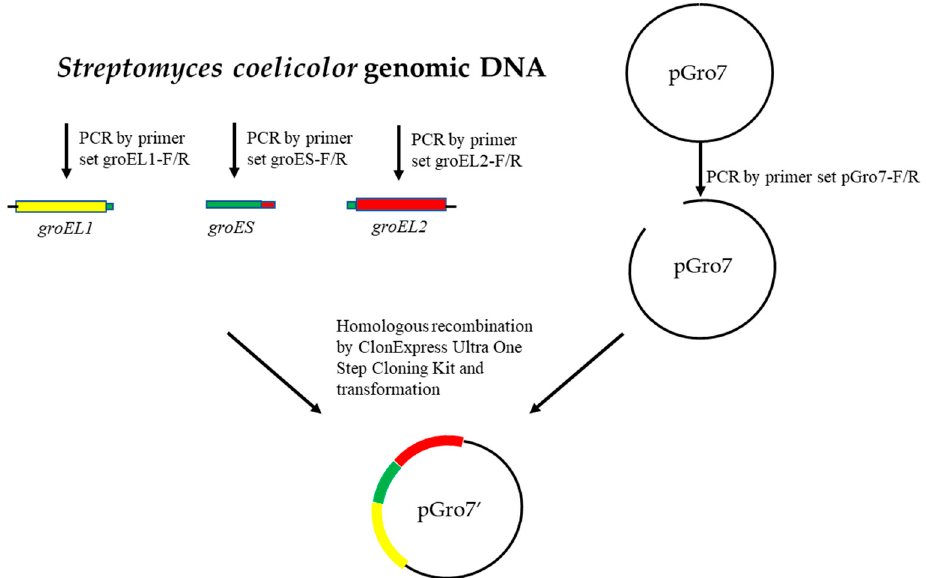
Figure 1. Construction process for the pGro7 ′ plasmid.